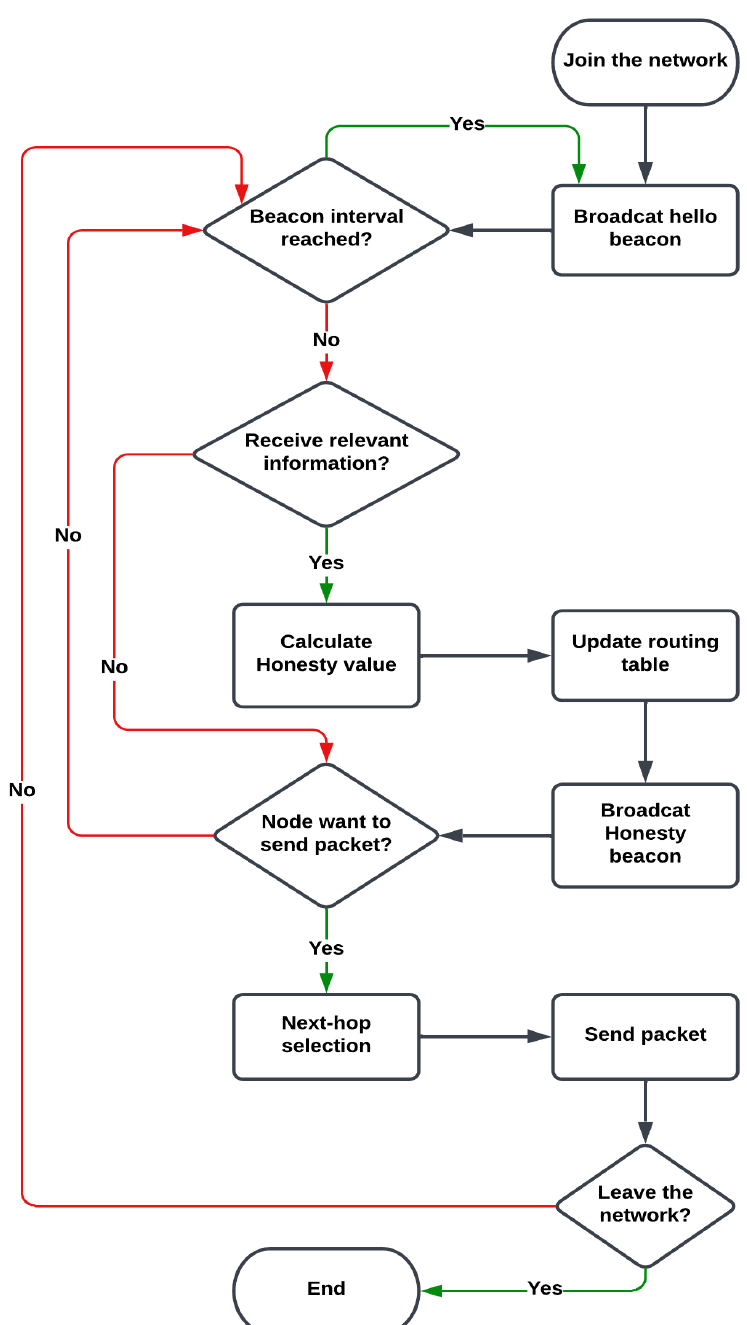
Figure 6. The flow chart of the entire working of the proposed protocol.